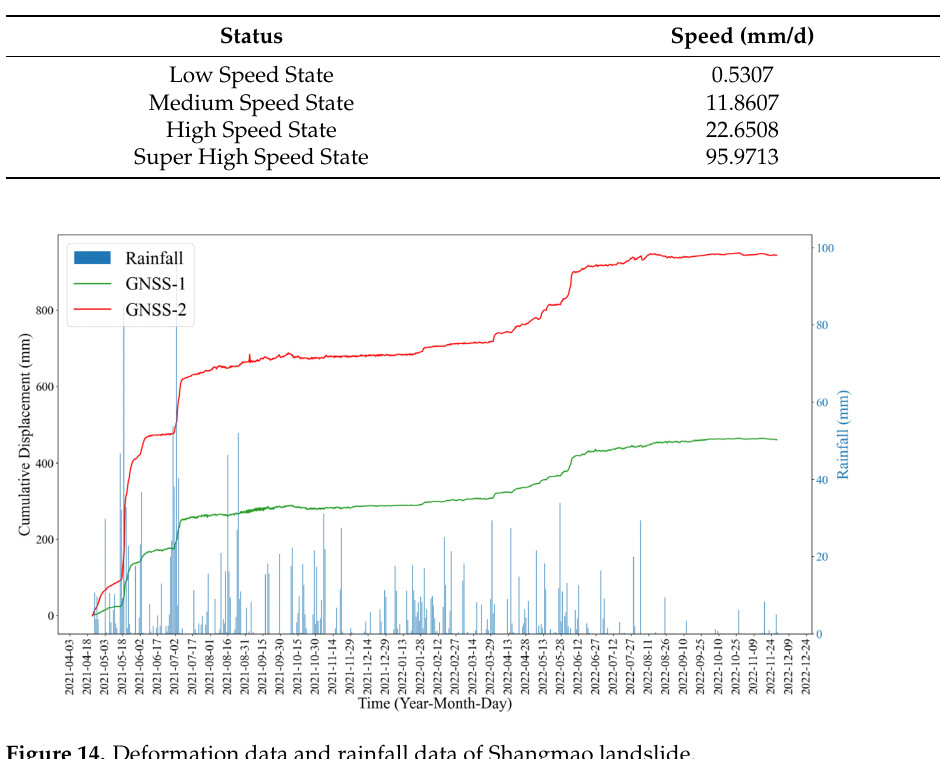
Table 4. Clustering centroids of the Shangmao landslide.